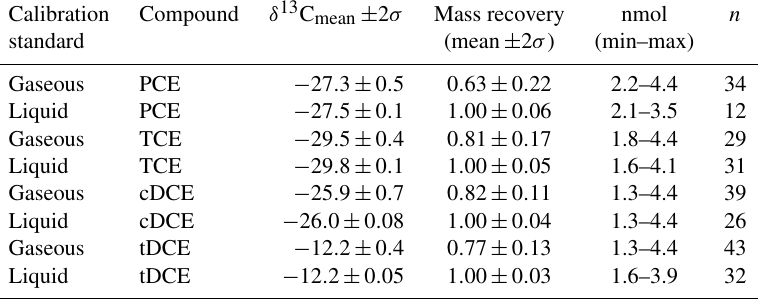
Table 1. Comparison of δ 13 C mean values ± twice the standard deviation (2 σ ) and mass recovery rates, as means ± 2 σ , obtained from measurements of gaseous and liquid calibration standard aliquots at the given mass range (nmol) of chlorinated ethenes (PCE, TCE, cDCE, tDCE) loaded to sorbent